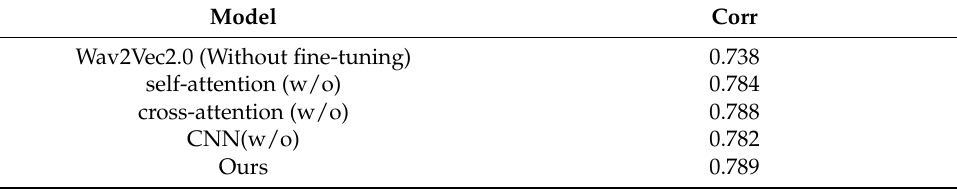
Table 13. Ablation study on